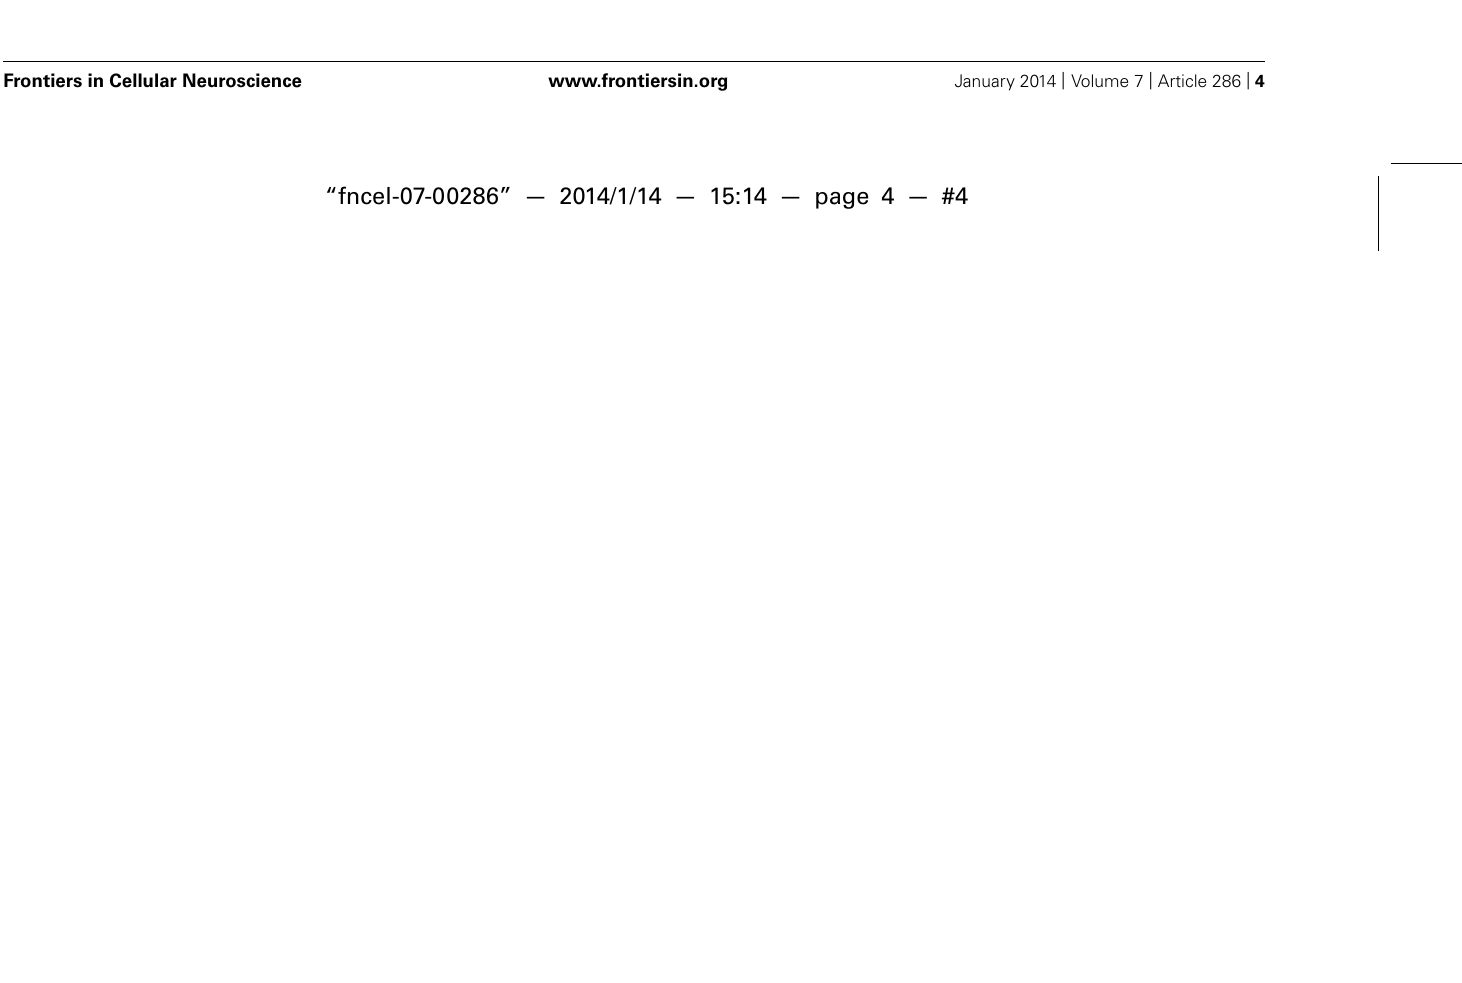
the primer sites for PCR genotyping. (C) PCR genotyping of littermates (numbers 1–8) obtained by crossing a VGAT flox / flox ; L7 Cre / + mouse with a VGAT flox / flox ; L7 + / + mouse. Upper and lower panels show the genotyping of the VGAT and L7 gene, respectively. Lanes 1–8 in both panels correspond to the identical littermate number. Lanes 9 and 10 in both panels were used as controls. Lanes 9 and 10 in the upper panel indicate the VGAT flox / + and VGAT flox / flox genotypes, respectively. Lanes 9 and 10 in the lower panel indicate the L7 Cre / Cre and L7 + / + genotypes,